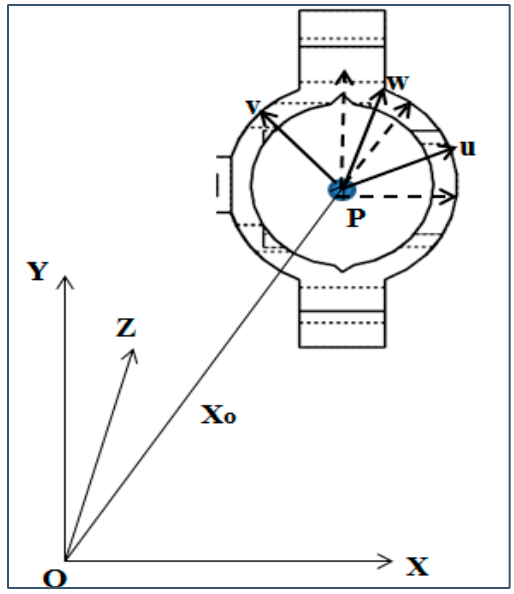
Figure 4. Holding fixture center positioning ( O : Center of joining the supports and holding clamp (Fixed center) and P : Center of the holding clamp circle (moving center)) .